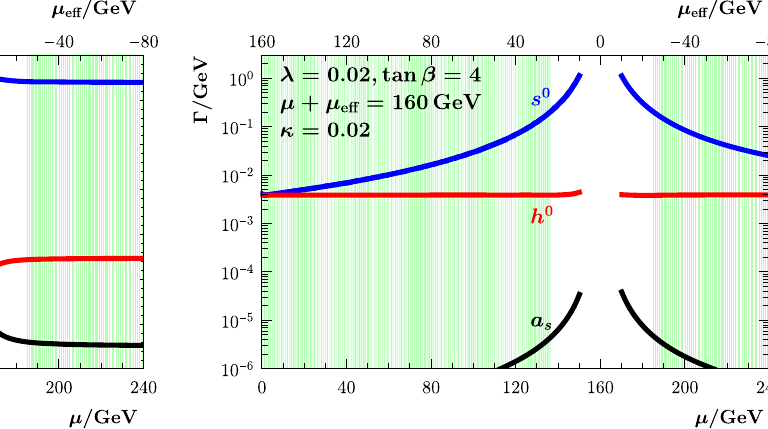
Fig. 9 The mass spectrum (left) and total decay widths (right) for the three lightest Higgs bosons in a scenario with small λ = 0 . 02 and fixed μ + μ eff = 160GeV are shown. The value of κ is rescaled as κ → ˜ κ according to Eq.(36) with κ = 0 . 02. Furthermore, | A κ | = 1 . 3GeV